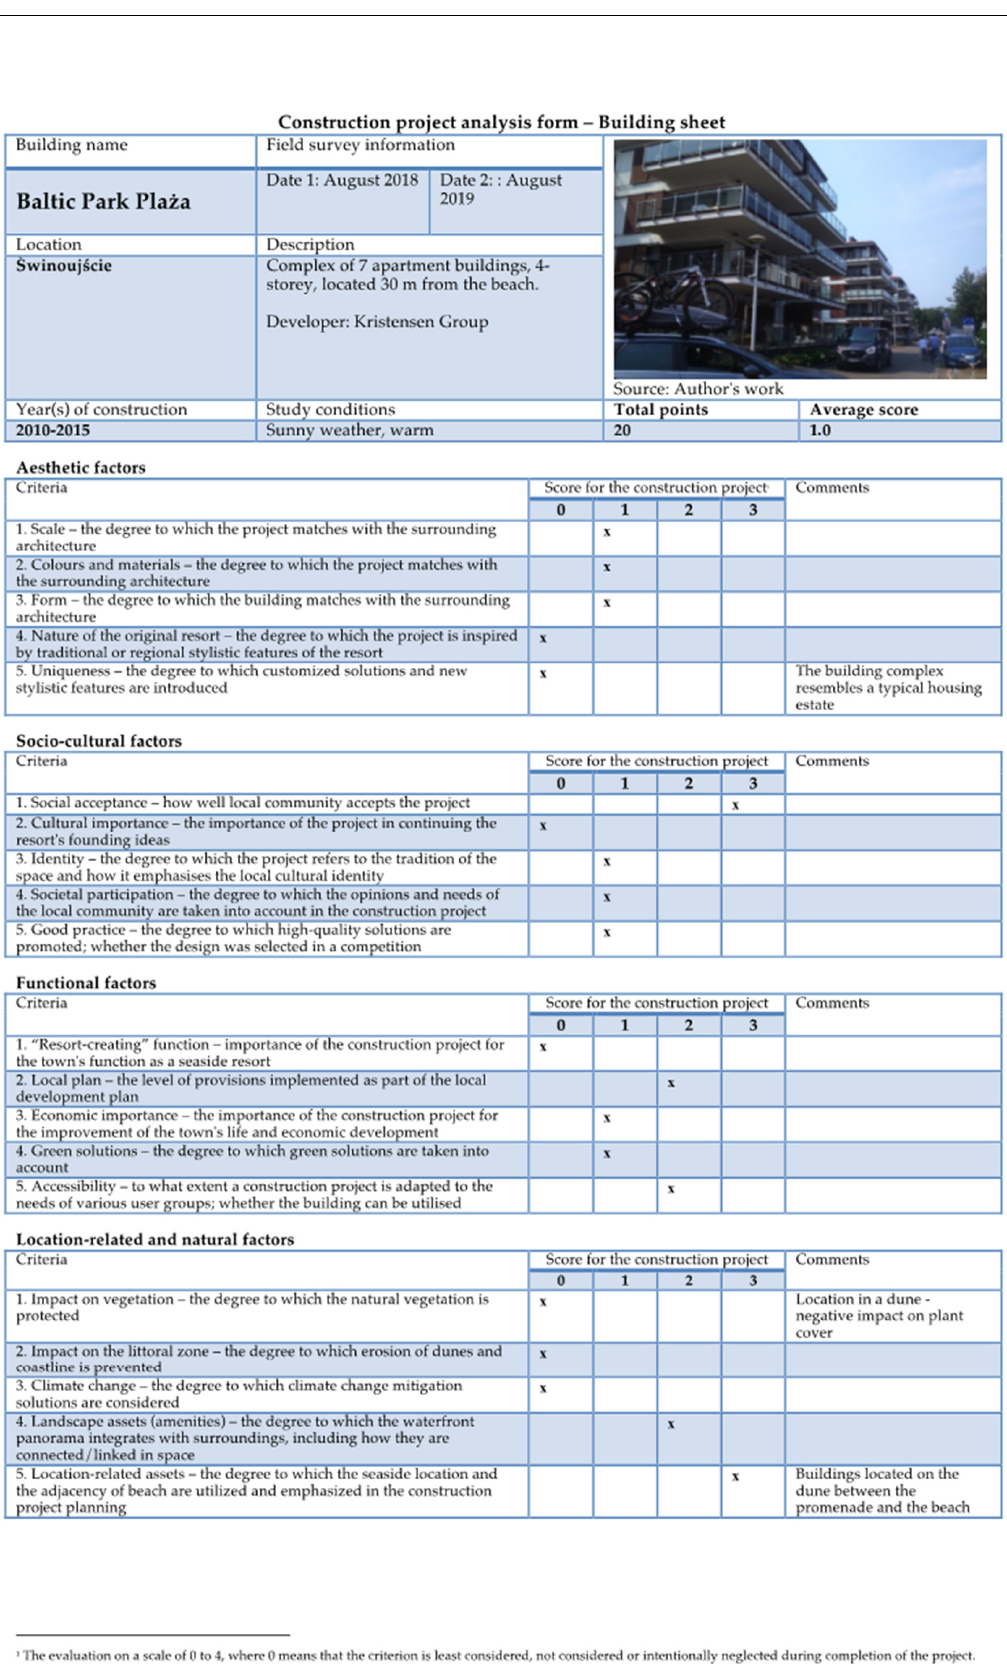
Figure A3. Baltic Park Pla ż a in Ś winouj ś cie. Building sheet.